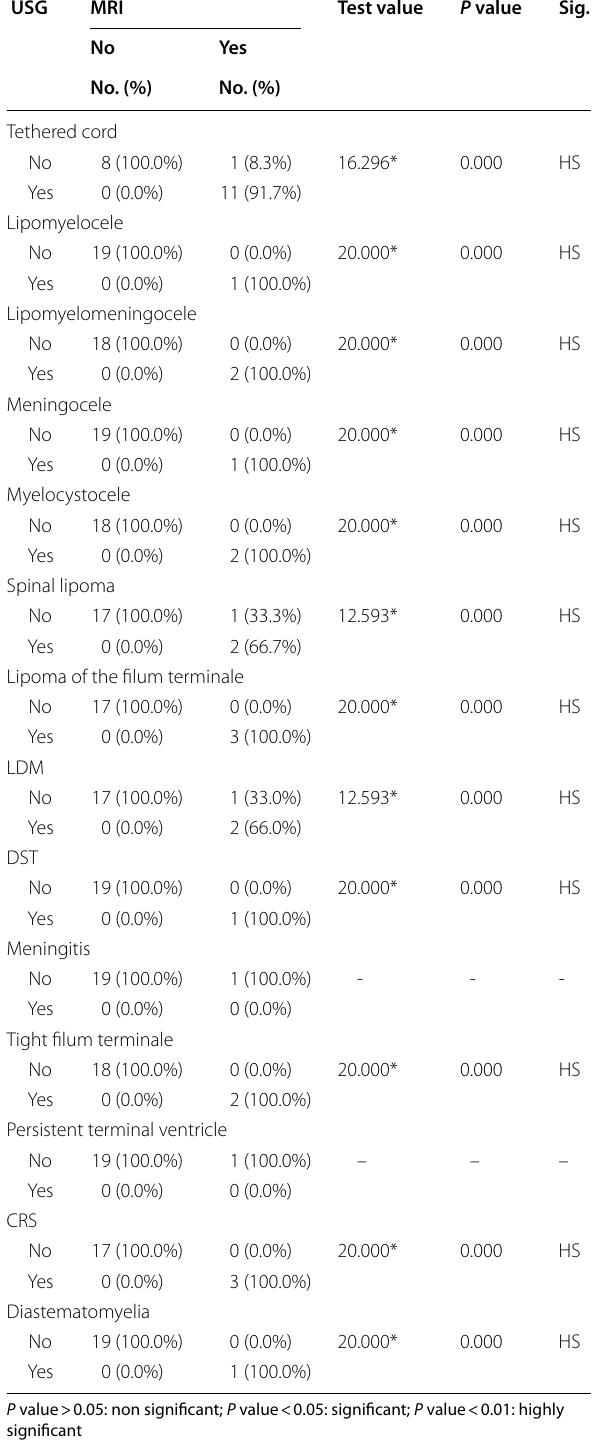
Table 7 Relation between USG and MRI as regarding diagnosis of each subtype of spinal dysraphism